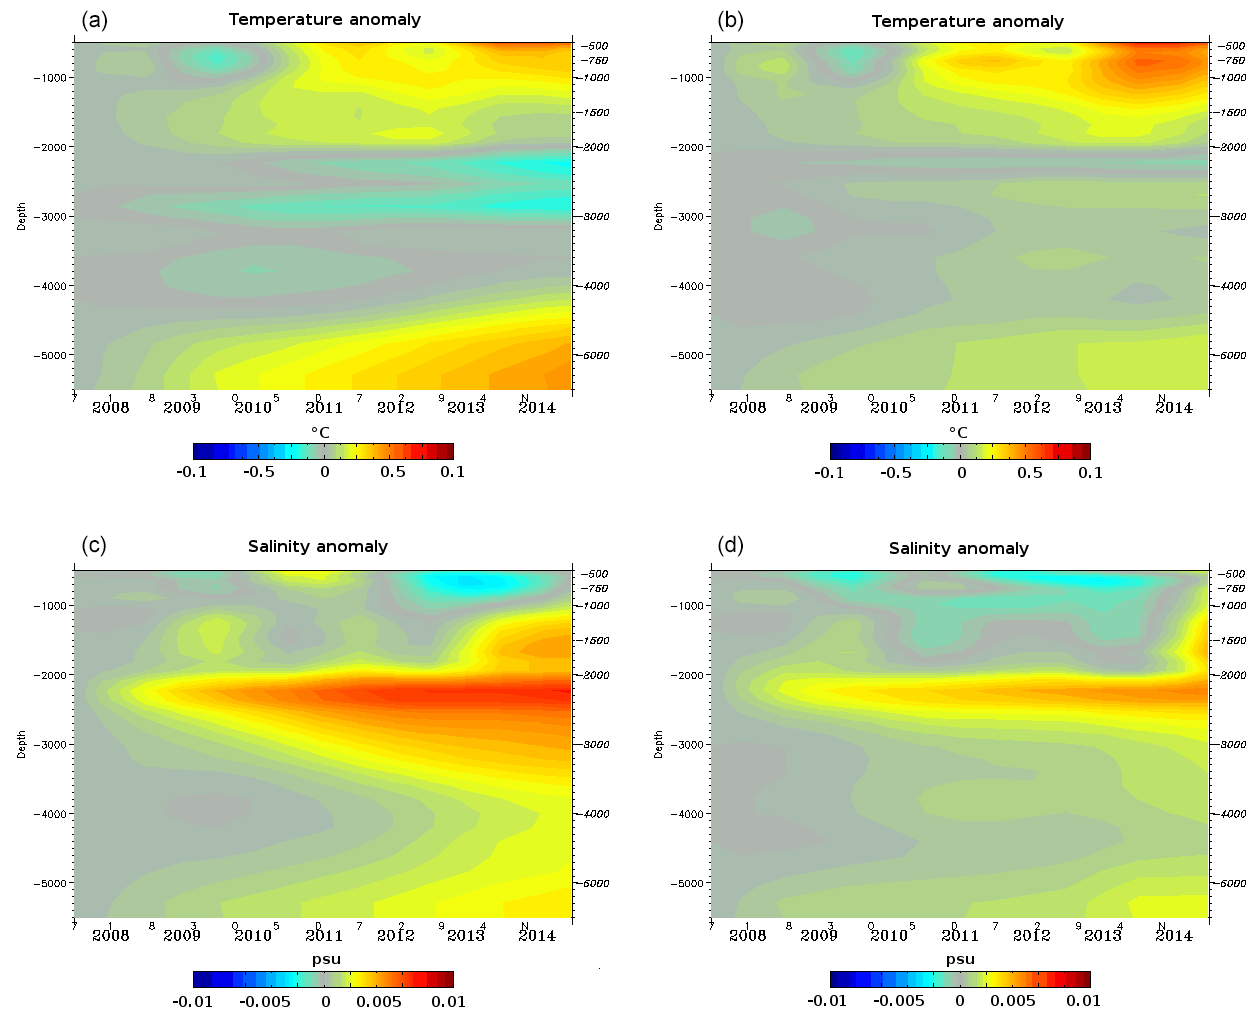
Figure 11. Temperature ( a, b , units in ◦ C) and salinity ( c, d , units in psu) annual anomalies over depth (500–5000m) and time (2007–2014) for latitudes between 30 and 60 ◦ S. The simulation in (a) and (c) does not assimilate climatological vertical profiles, while the simulation in (b) and (d) assimilates them. Annual anomaly for a specific year is computed as the difference between the annual mean of this year and the annual mean of the year